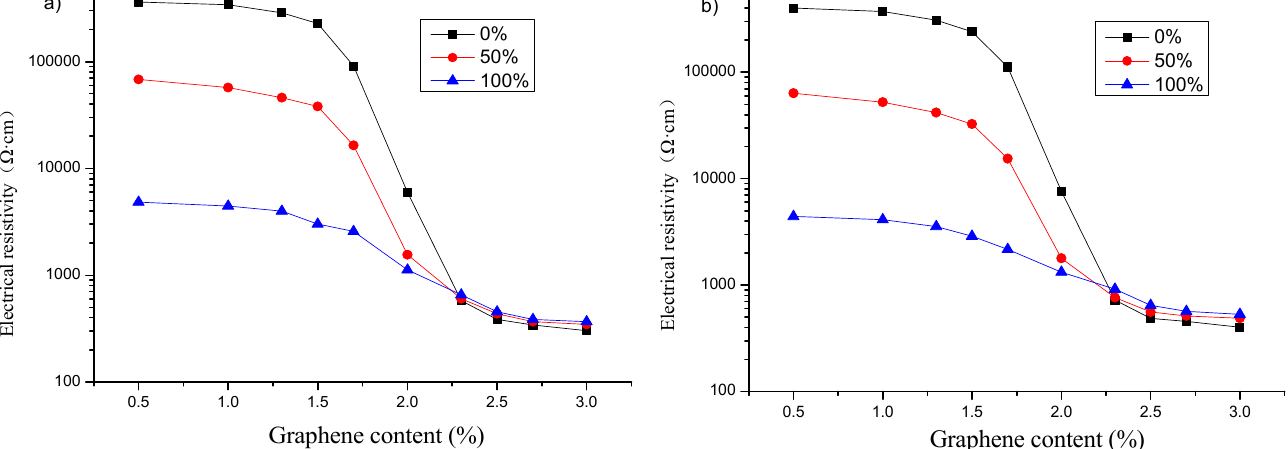
Figure 10. Effect of relative water content on electrical resistivity of specimens with different graphene content: ( a ) before 50 freeze–thaw cycles; ( b ) after 50 freeze–thaw cycles.